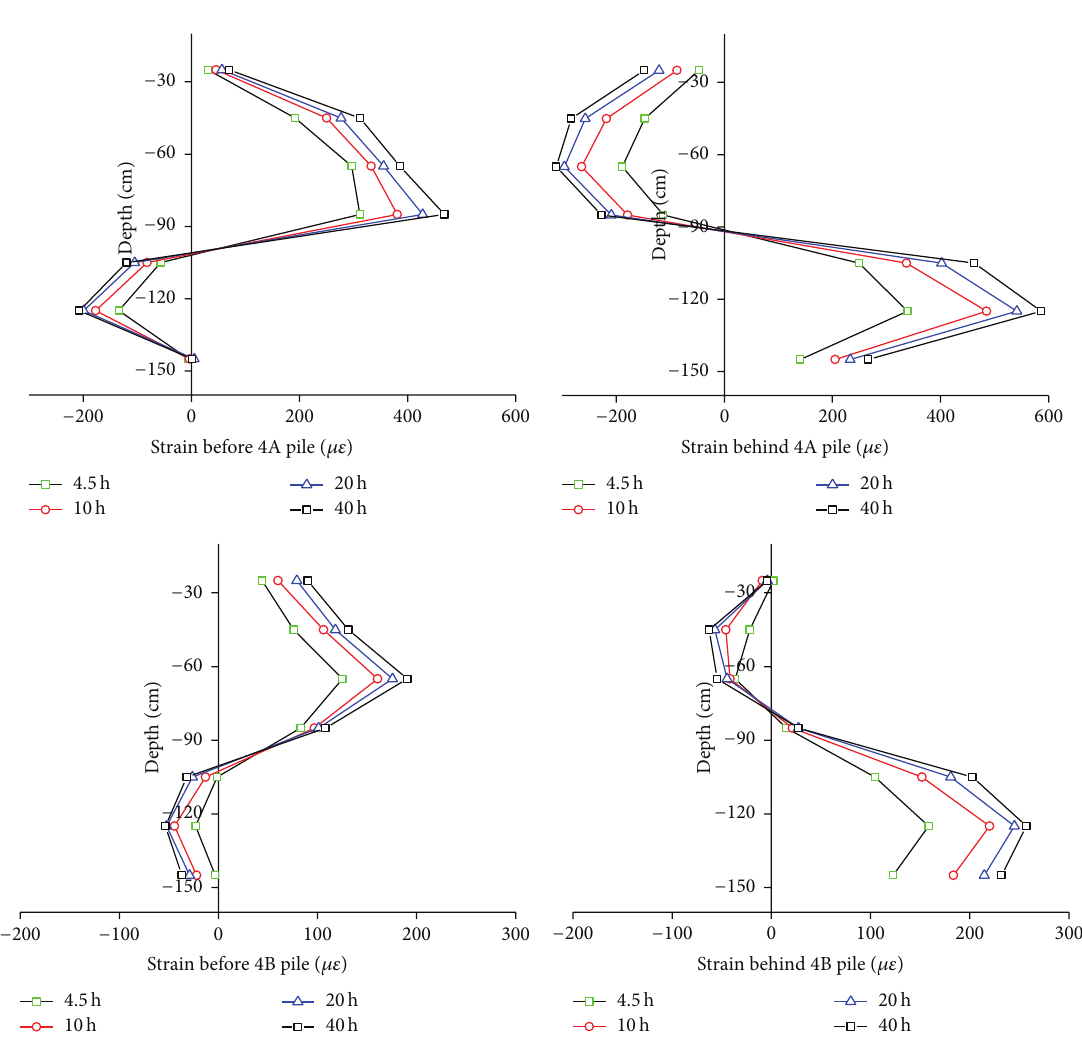
Figure 13: The morphology of strain of 4A and